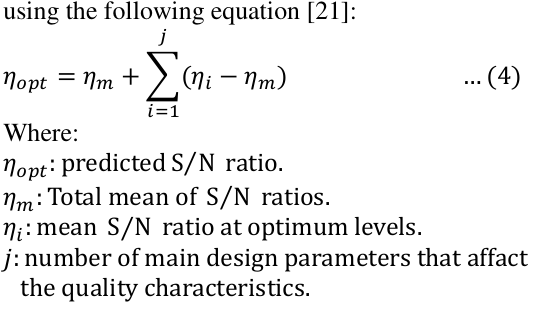
Sum of Squares (SS)